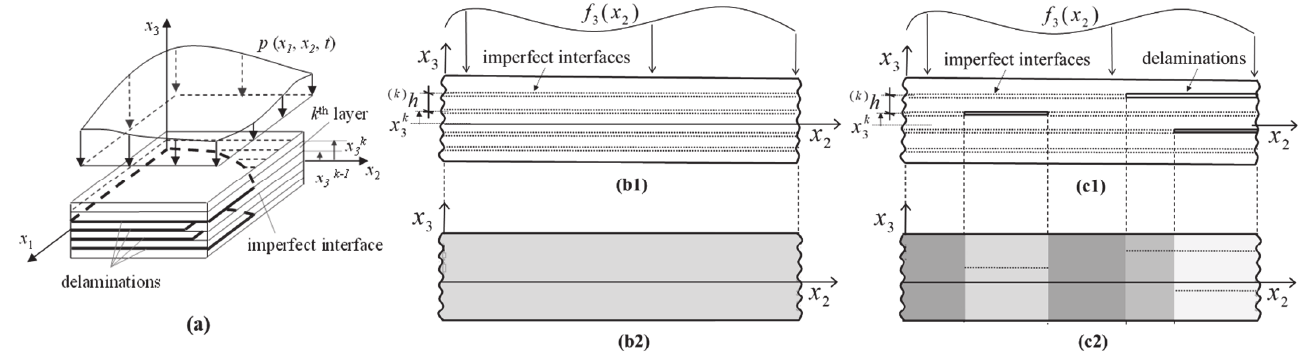
Figure 1: (a) n -layered plate with weakly bonded layers modelled as imperfect interfaces and delaminations; (b1,2) n -layered beam with imperfect interfaces and related homogenized description; (c1,2) n -layered beam with imperfect interfaces and delaminations and related homogenized description. The homogenized description eliminates the need for through-thickness and longitudinal discretization in the presence of continuous imperfect interfaces (b2), and requires only longitudinal discretization in the presence of delaminations, (c2).